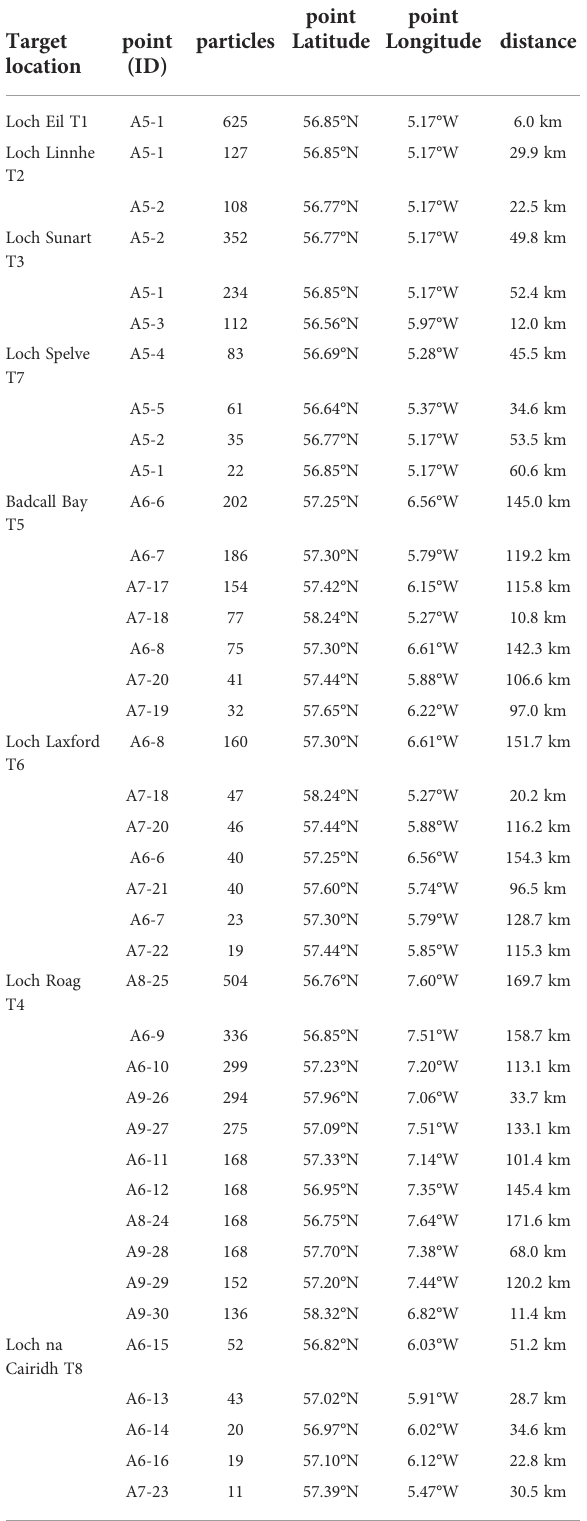
TABLE 2 Identi fi cation of the major source points contributor for each target